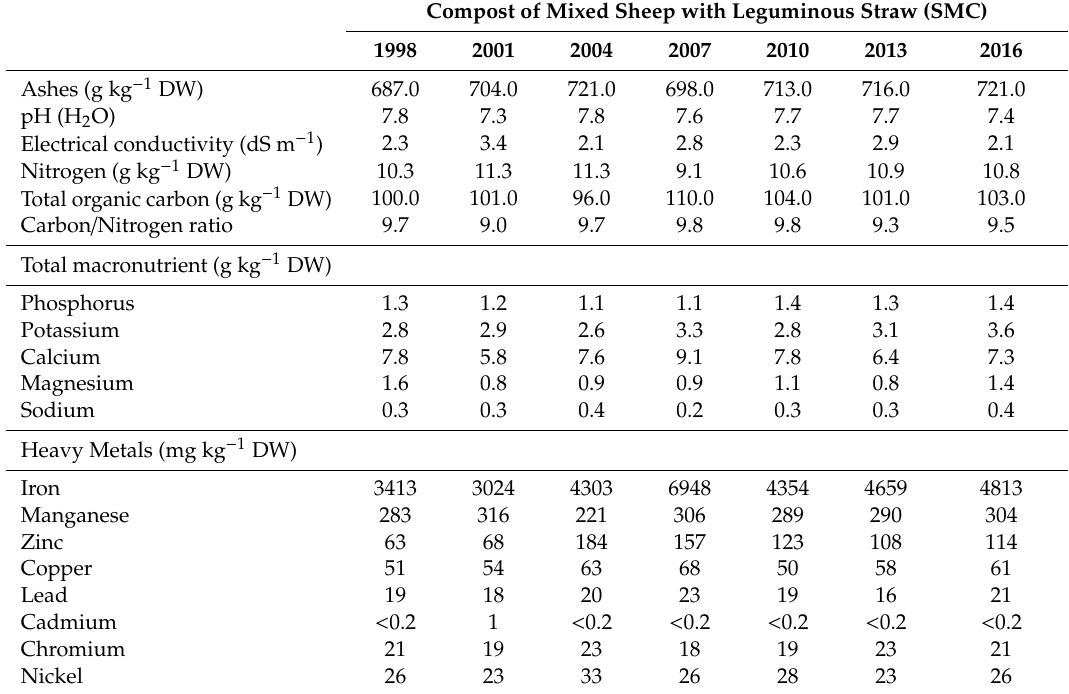
Table 6. Main analytical characteristics of the compost obtained from the mixture of sheep manure with leguminous straw (SMC) and applied to the soil in the years of